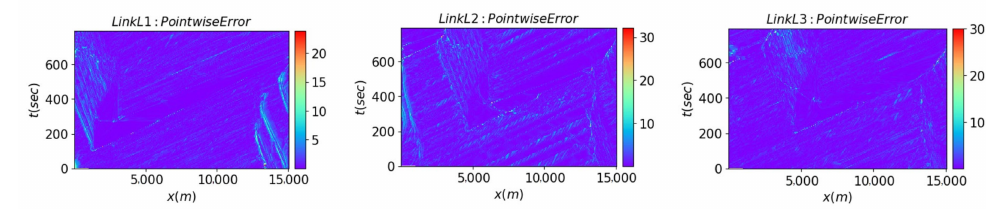
Figure 8. Pointwise error of Links L1, L2, and L3.